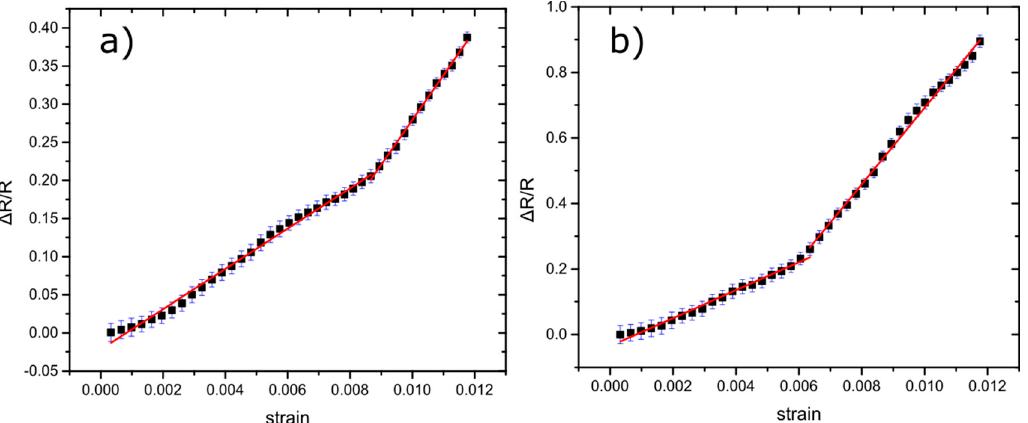
Figure 9. ( a ) Relative resistance change over strain graph for a sensor right after the alumina deposition. Error bars represent the standard deviation of the measurements. Two straight lines were used to fit, accurately, the experimental results as our model has proposed. In this example, the sensor has GF1~20 for lower strains and GF2~50 for higher strains. ( b ) Relative resistance change over strain graph for a sensor with alumina coating after 1000 stress cycles up to 1.2% strain. The sensor has GF1~60 for lower strains and GF2~85 for higher strains.